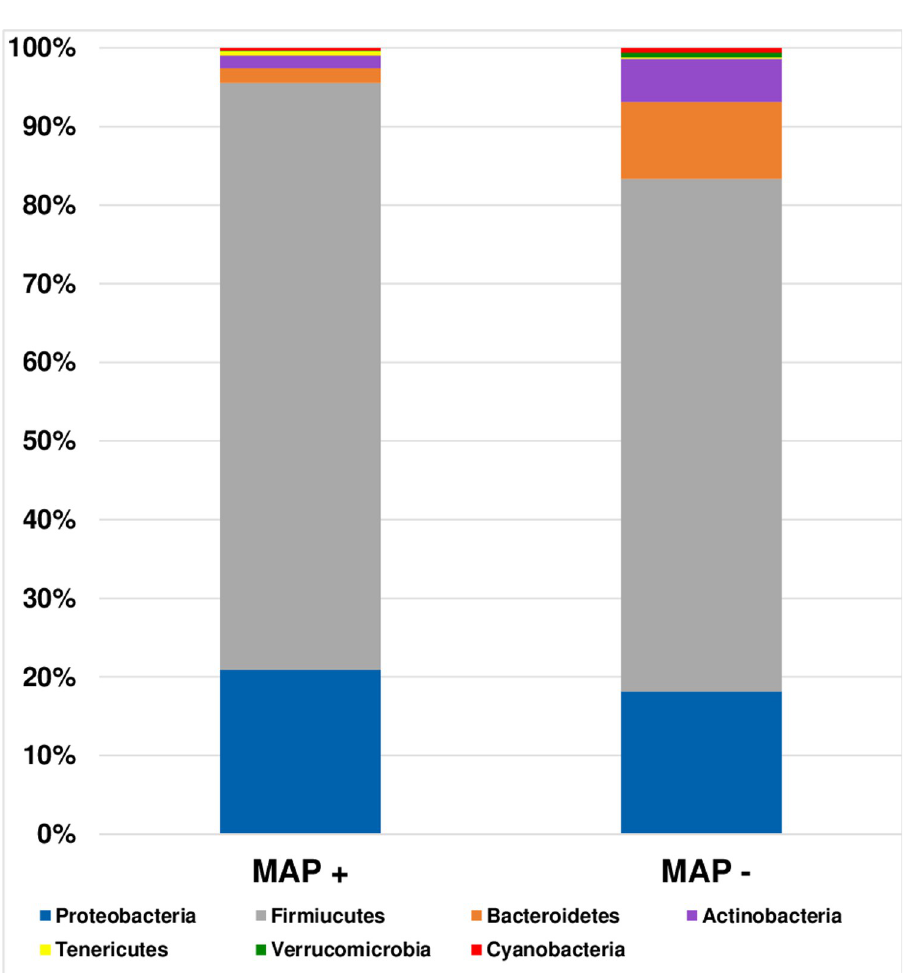
Fig 3. Phylum level faecal microbiome composition in MAP+ and MAP-